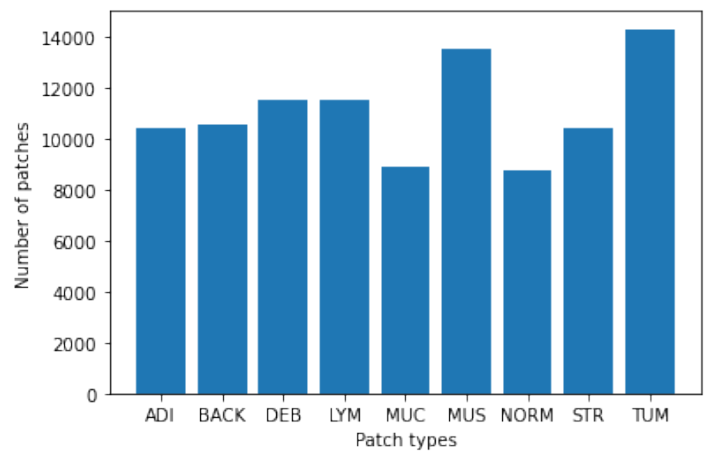
Figure 4. Number of patches in each tissue class.